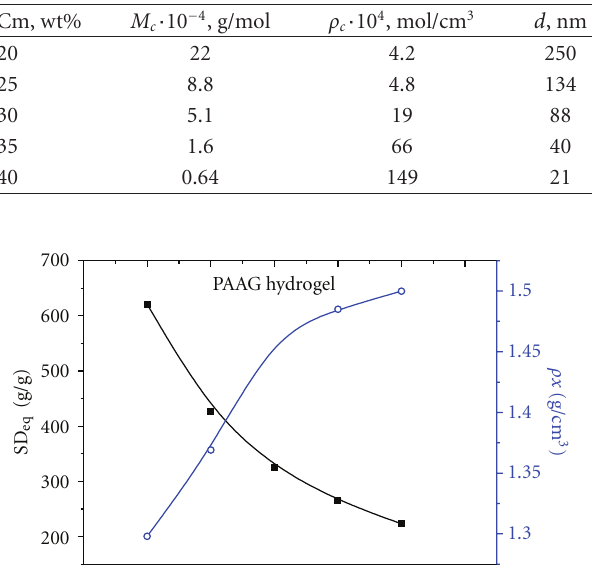
Table 4: E ff ect of monomer concentration on primary structural parameters of PMA xerogels.